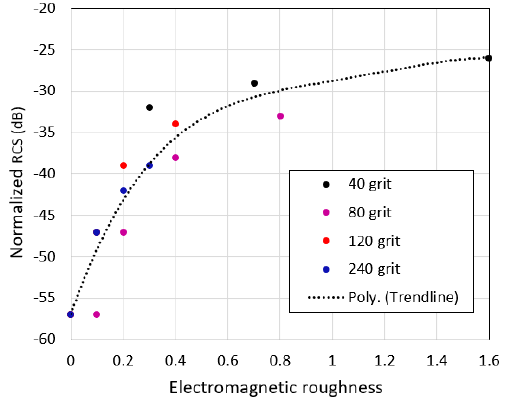
Figure 8. The normalized RCS σ 0 as a function of electromagnetic roughness at a grazing angle VV of 10°.